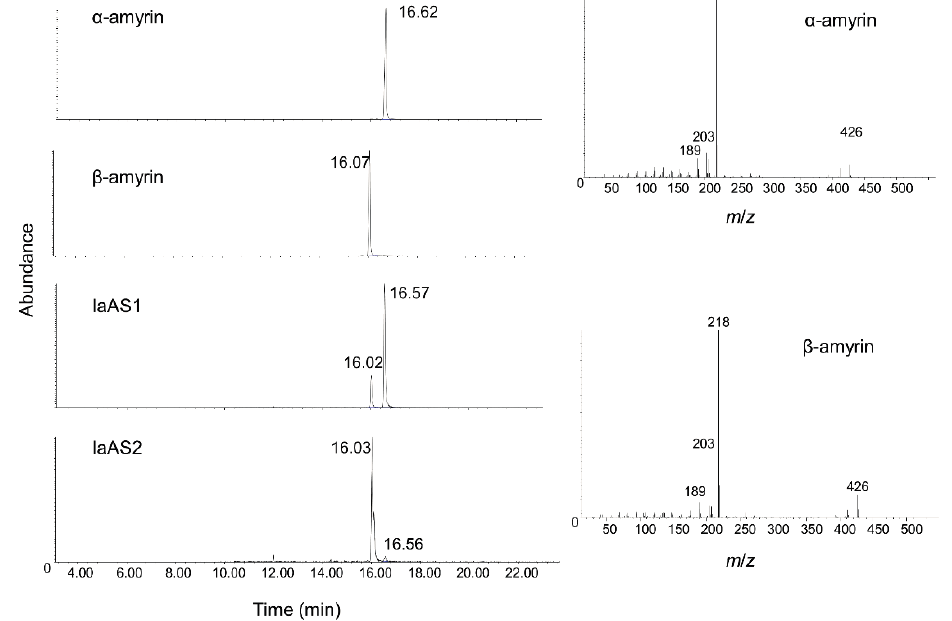
Figure 5. GC-MS (with an Electron Impact source) analysis of transient IaAS1 and IaAS2 expression. Products were monitored on the basis of the intensity of the base peak ( m / z 218), with α -amyrin and β -amyrin as standards. Two peaks identified in both IaAS1 and IaAS2 exhibit the same retention time and MS fragments as the